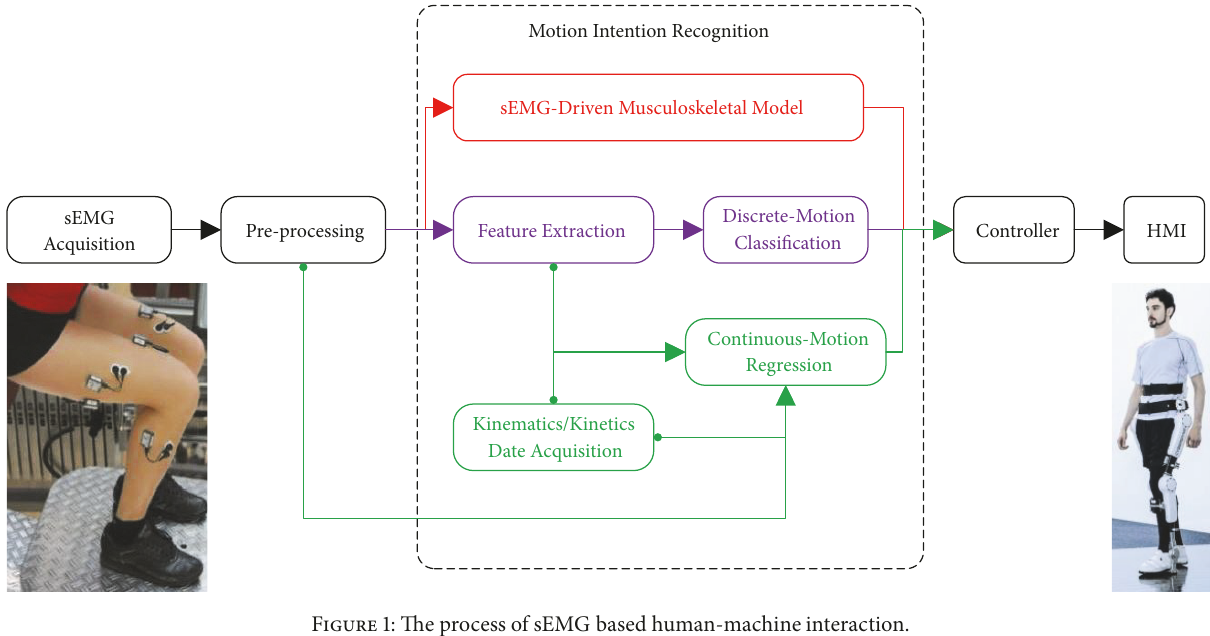
Figure 1: The process of sEMG based human-machine interaction.